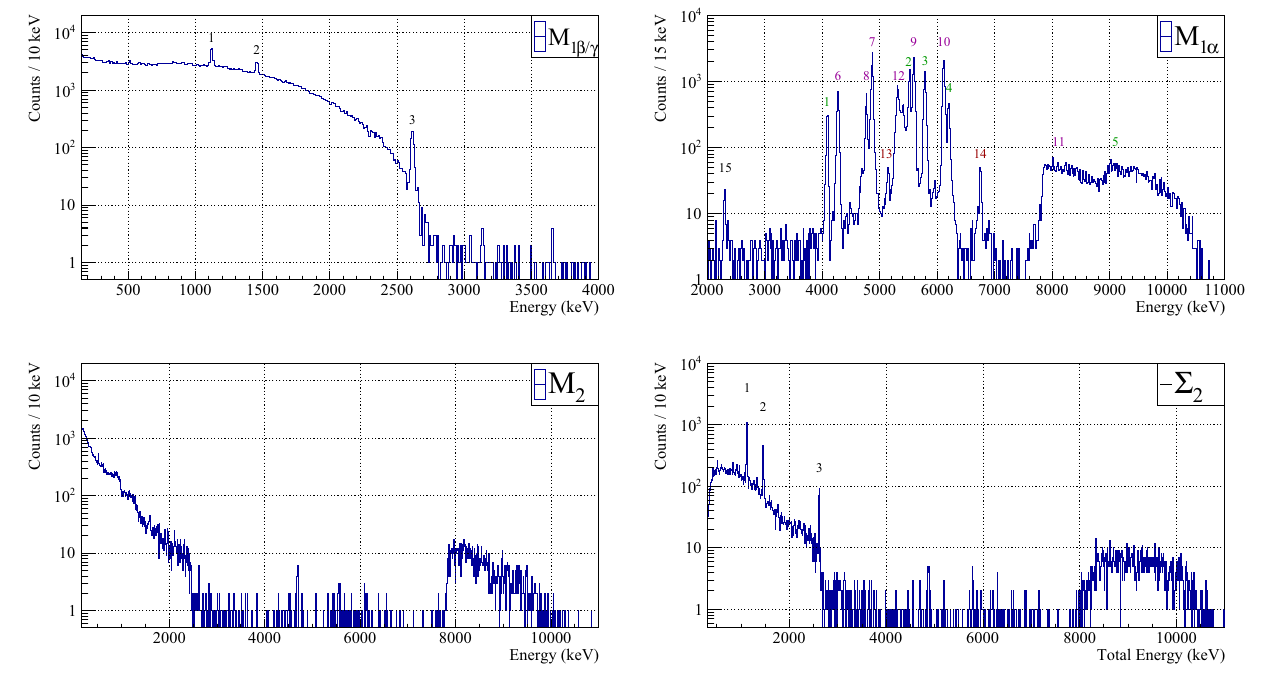
Sm. Bottom left: M 2 spectrum. Bottom right: Σ 2 spectrum with the same labels used for M 1 β/γ